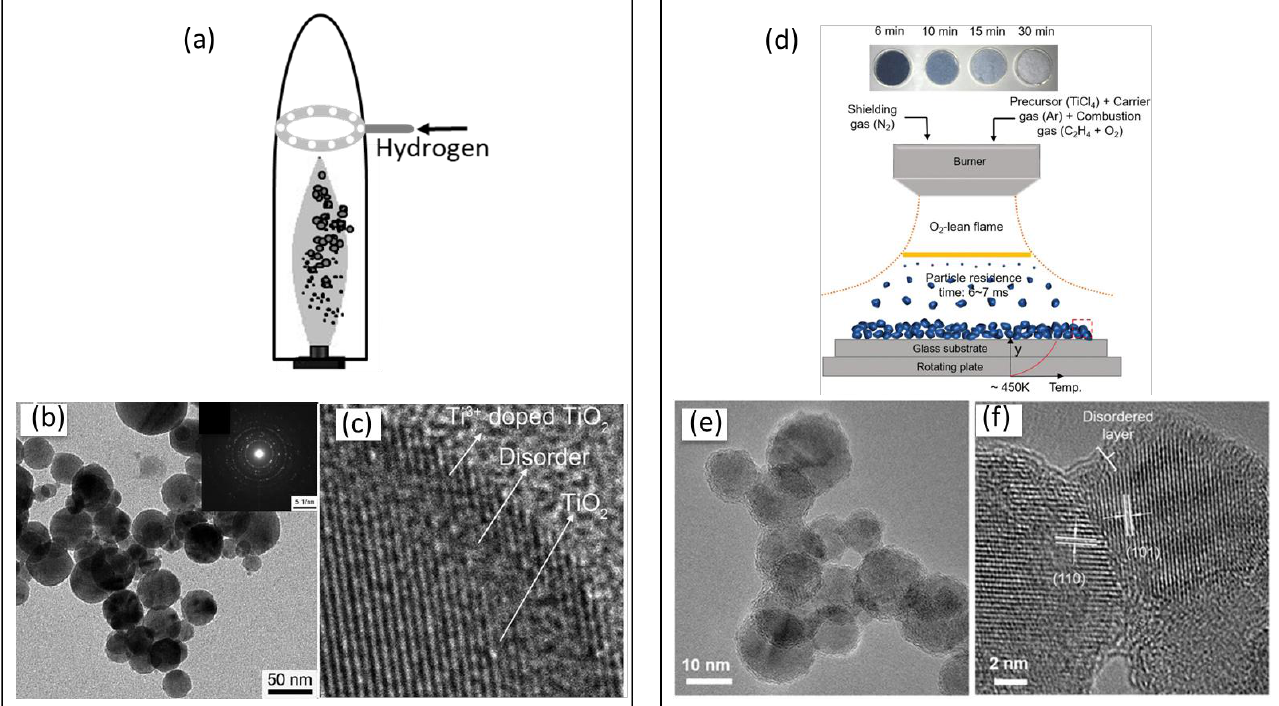
Figure 4. Synthesis of the defected TiO 2 prepared by two flame reactors. The in situ hydrogenation reactor: ( a ) reactor setup; ( b , c ) TEM and HR-TEM images of powder prepared from the in situ hydrogenation reactor (Re-printed/adapted with permission from Ref. [84]. Copyright 2014, the Royal Chemical Society). Flame stabilized on a rotating surface (FSRS): ( d ) FSRS setup; ( e , f ) TEM and HR-TEM images of the formed product at a 6 min deposition time (Re-printed/adapted with permission from Ref. [86]. Copyright 2020, John Wiley and Sons).